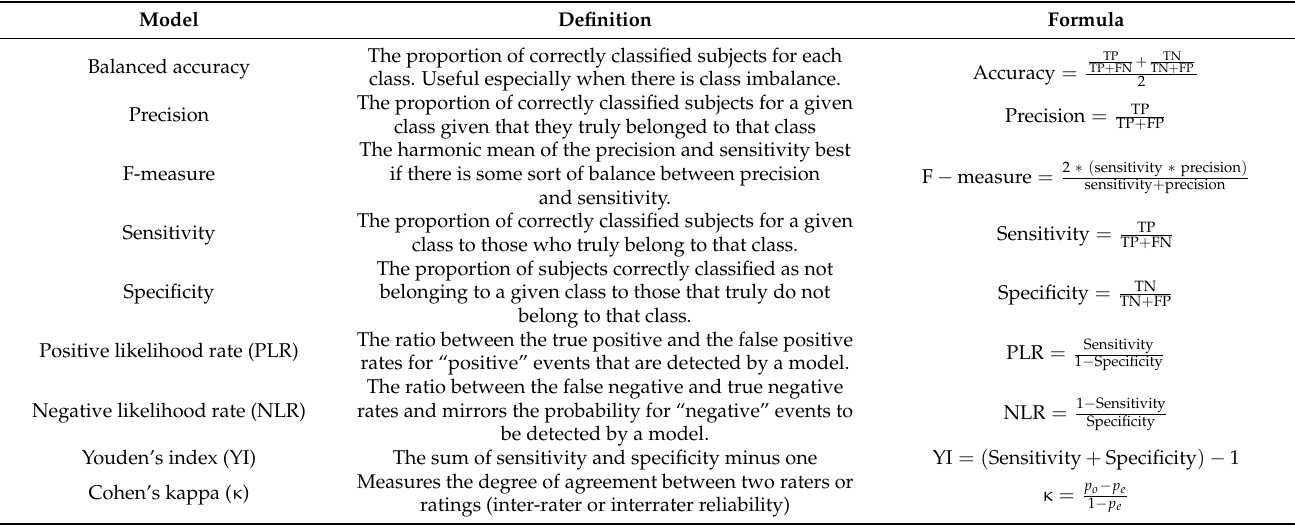
Table 1. Model performance evaluation